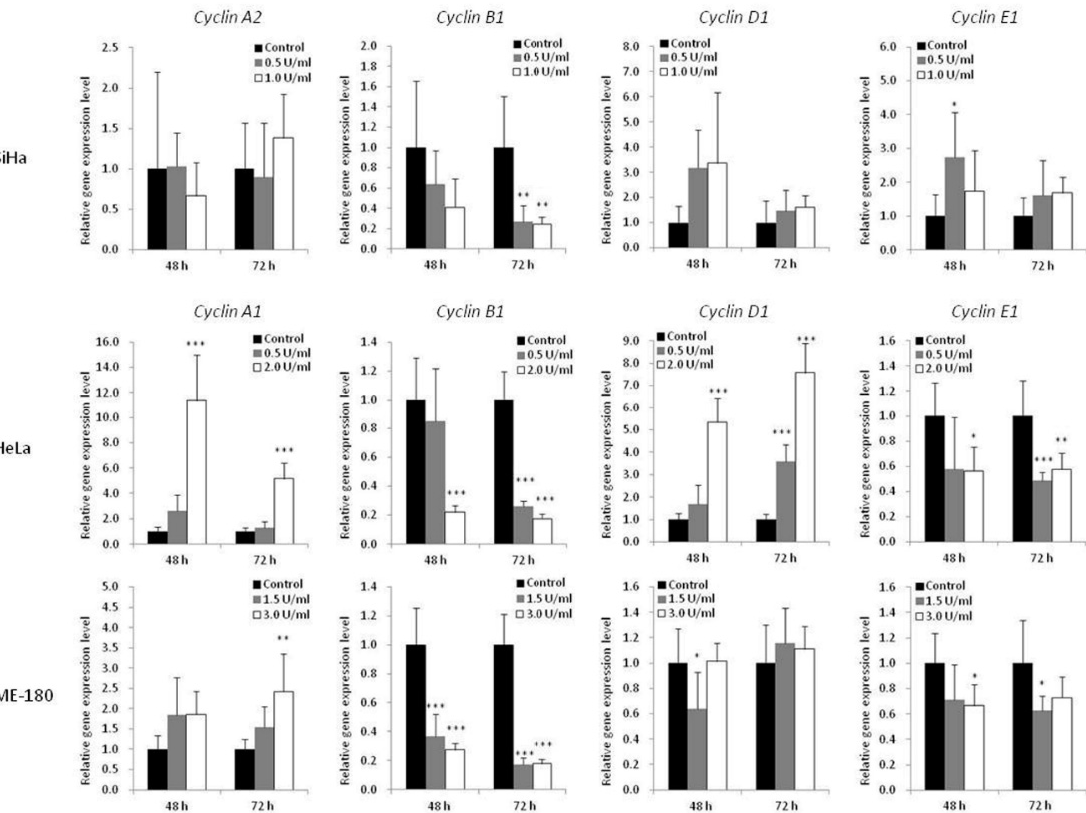
Figure 6. Effect of BCA-M on relative gene expression levels of various cyclins in SiHa, HeLa and ME-180 cells. The relative gene expression levels were determined using real-time PCR and normalized with the expression levels of the internal control (GAPDH, data not shown) and that of the respective genes in drug treatment control. The results were shown as means and S.D. One-way ANOVA with post hoc Dunnett’s test showing p values for comparison between control and treatment as: * p < 0.05, ** p < 0.01, *** p < 0.001.